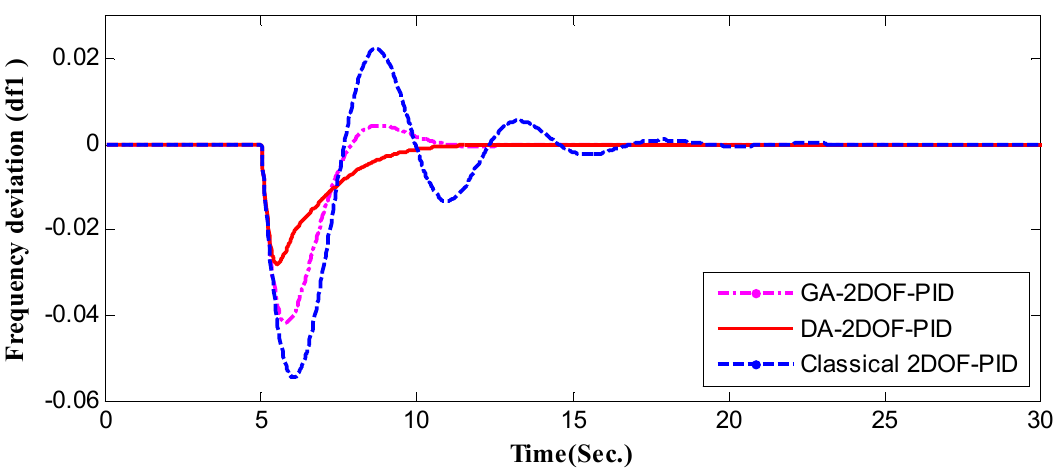
Figure 23. Δ P using GA-2DOF-PID, DA-2DOF-PID, and classical-2DOF-PID with ITAE. Figure 23. ∆ P using GA-2DOF-PID, DA-2DOF-PID, and classical-2DOF-PID with ITAE.